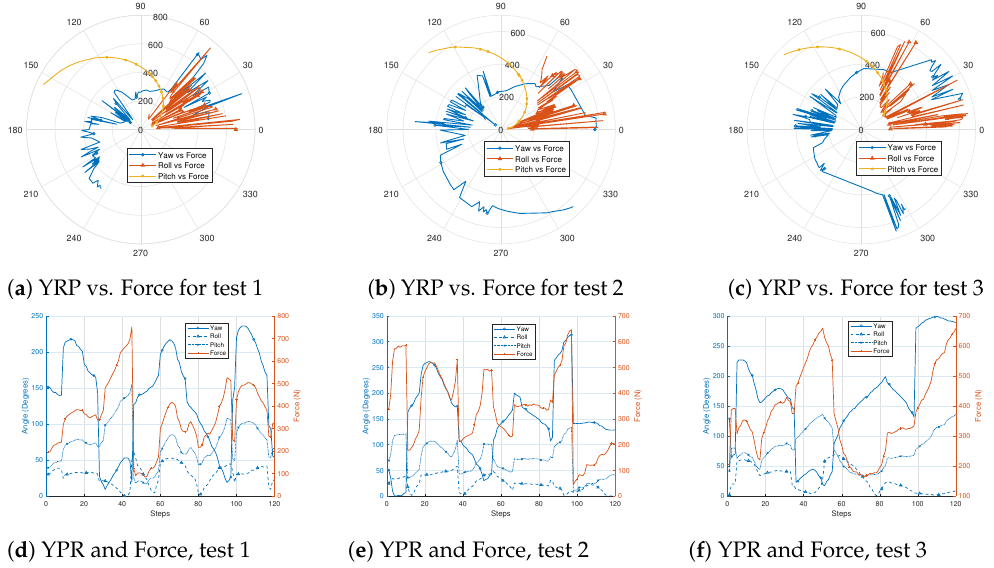
Figure 17. Tether force simulation for three test cases: ( a – c ) polar plots of the YRP vs. force; the sweep represents the angles (0 ◦ to 360 ◦ ) and the magnitude represents the tether force, ( d – f ) time-series plots of the YRP and the tether force under turbulent wind